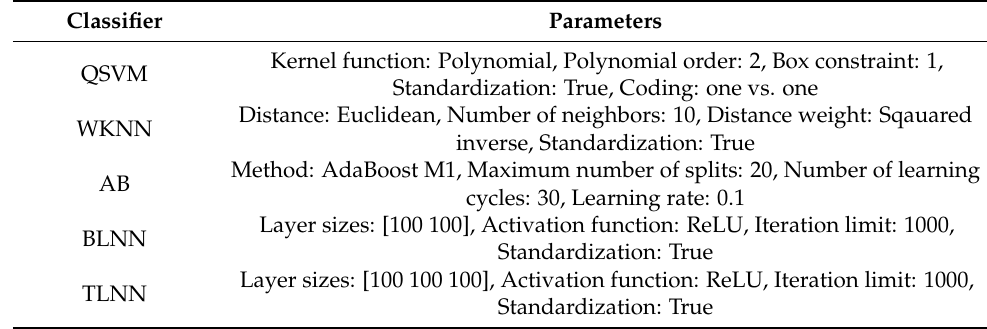
Table 4. Hyperparameters used for each classifier.